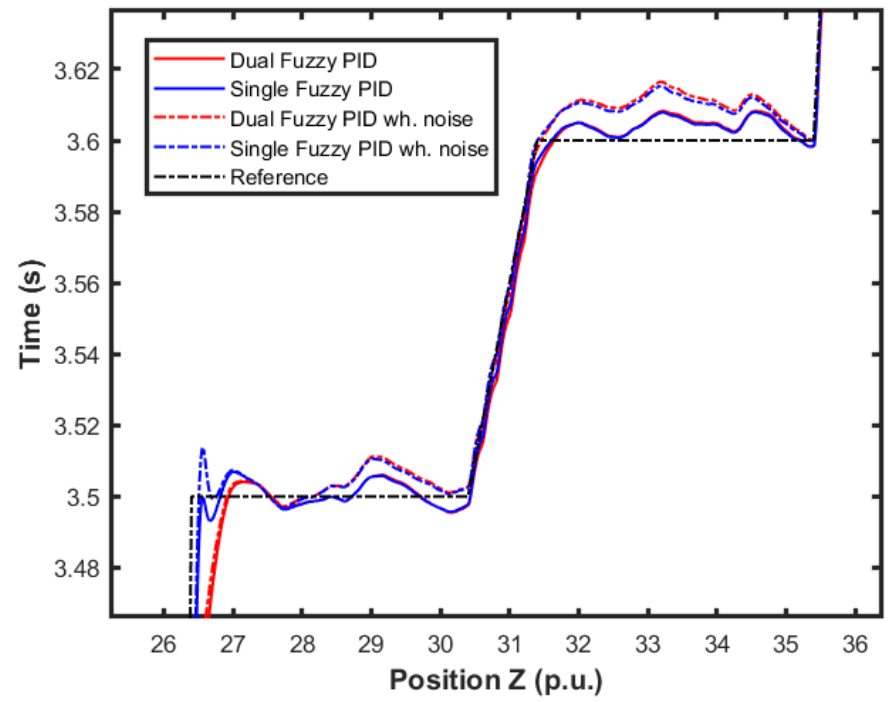
Figure 19. UAV height response details.